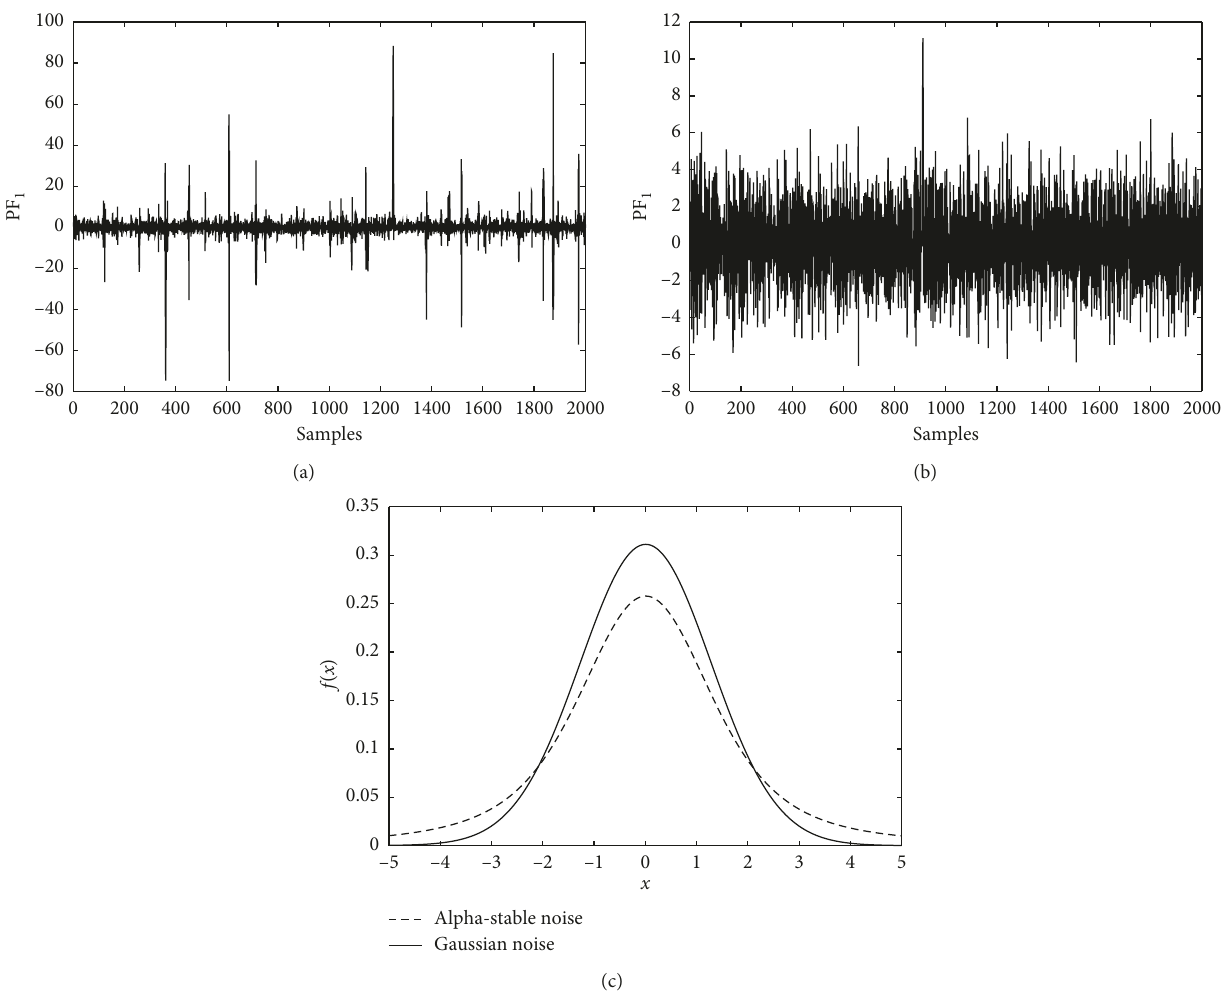
Figure 2: PF ( t ) components and comparison of PDF tail heaviness. Product function of the analog signal when (a) z 1 (c) Comparison of PDF